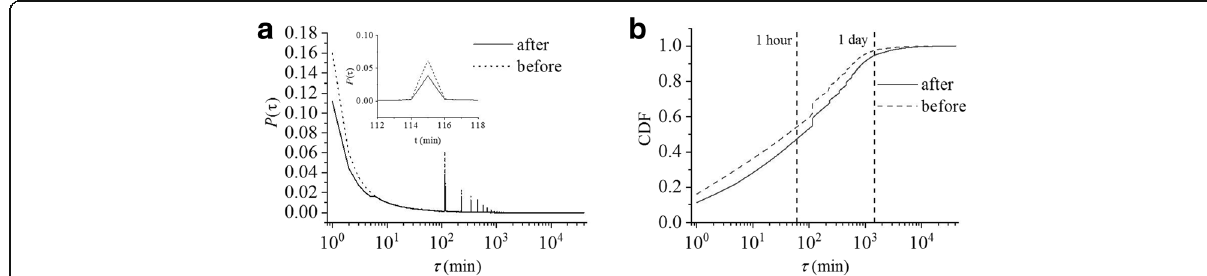
Fig. 8 Stay time distribution comparison between before and after using the heuristic strategies. a Probability distribution. b Cumulative